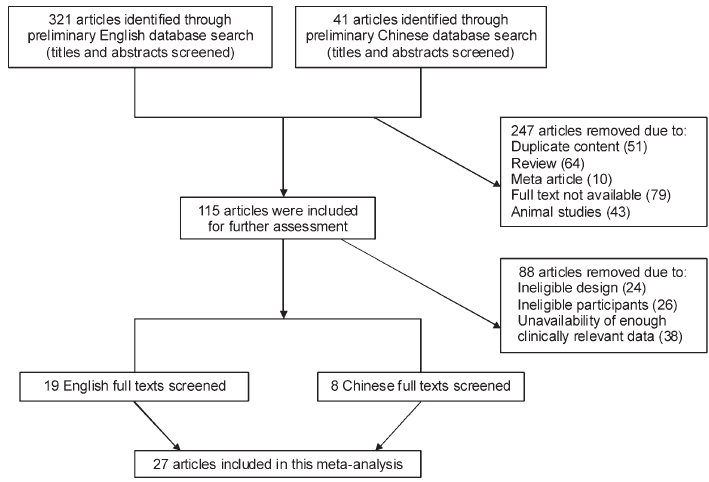
Figure 1. Flow diagram of the selection of articles for inclusion in the